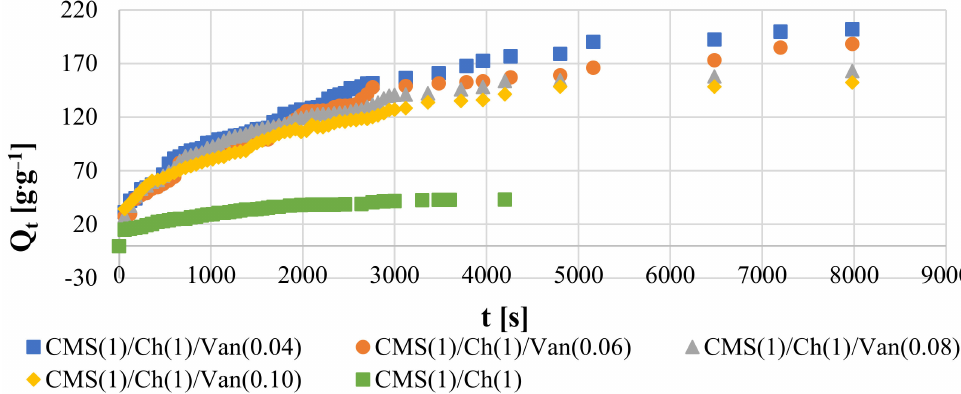
Figure 7. Swelling kinetic curves at 298